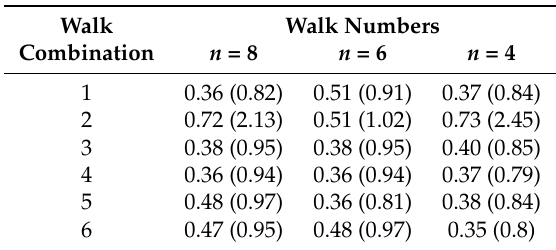
Table 4. Mean position error ¯ e and maximum error e max (in brackets) of 6 walk combinations of 8/6/4 pedestrians starting at different starting positions in front of the building for partly successive FeetSLAM. The number of iterations was 3 and the window size was 3. Walk Walk Numbers